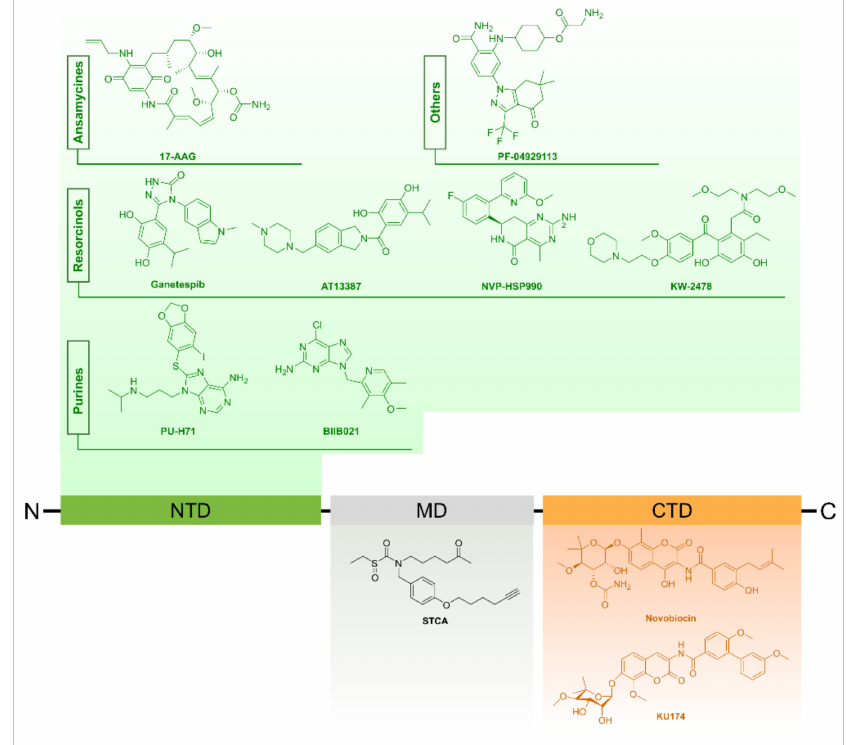
Figure 4. Common small inhibitors of